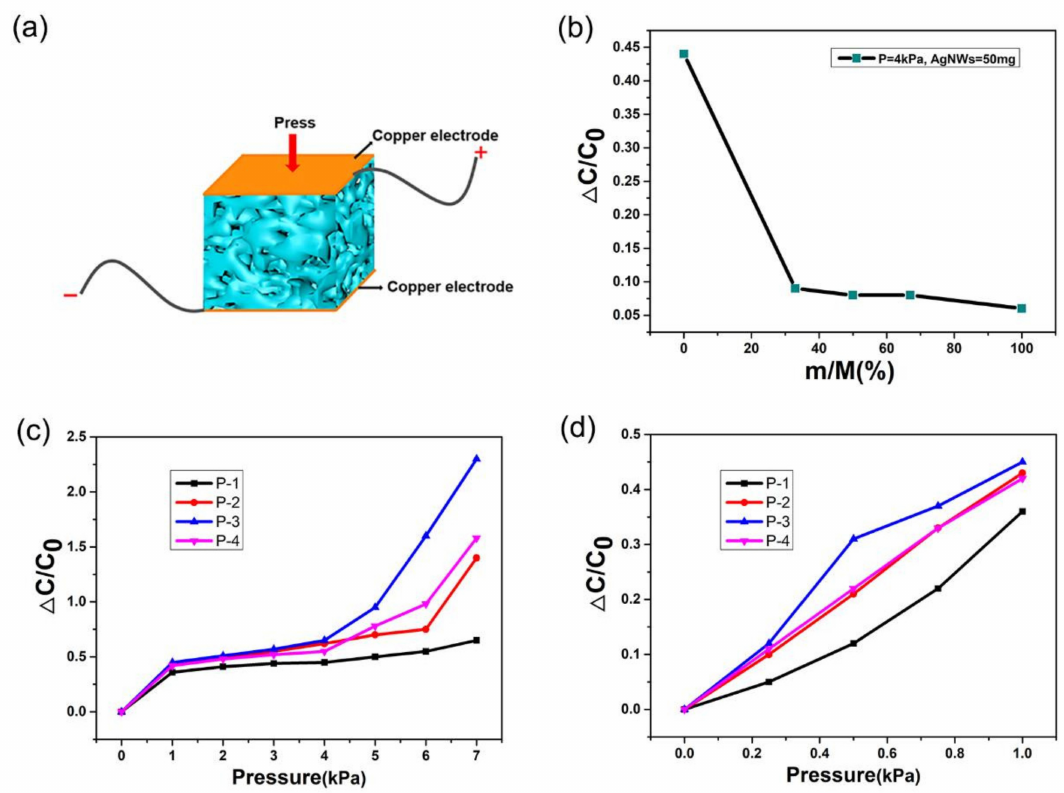
Figure 2. ( a ) Schematic of the PAP sponge capacitive pressure sensor structure. ( b ) The change curve of the capacitance change rate of PAP sponge by content of soft white sugar in the template. ( c , d ) Sensitivity curves of the capacitive pressure sensor with different load amounts of AgNWs under applied